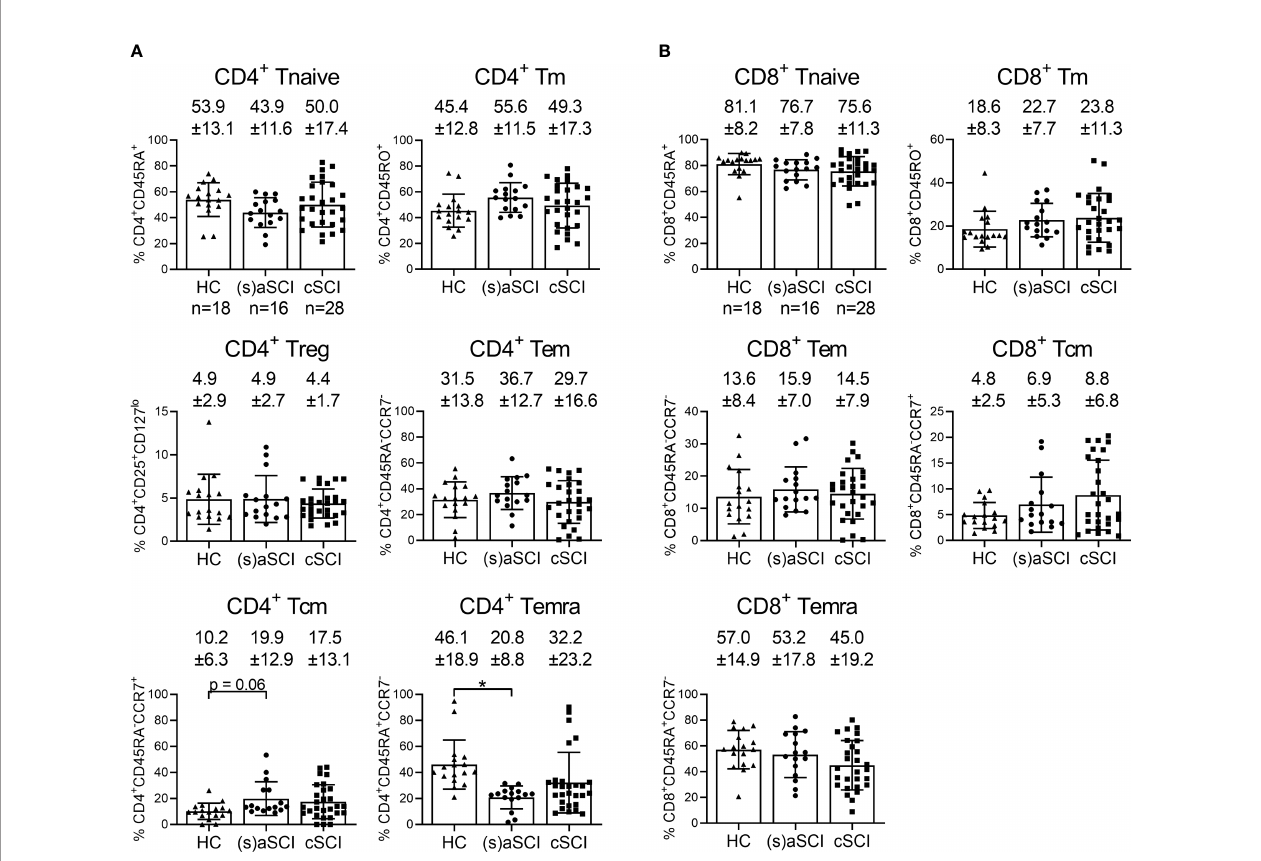
FIGURE 3 | Frequency of T cell subsets in the peripheral blood of HC and SCI patients. Percentages of CD4 + (A) and CD8 + (B) Tnaive, Tm, Tem, Tcm and Temra are shown within the lymphocyte population of HC (n = 18) and SCI patients (n = 18), including (s)aSCI (16 samples) and cSCI (28 samples), as indicated in the fi rst graph of each fi gure panel. Mean (bars) ± SD is depicted and shown in numbers. *p <